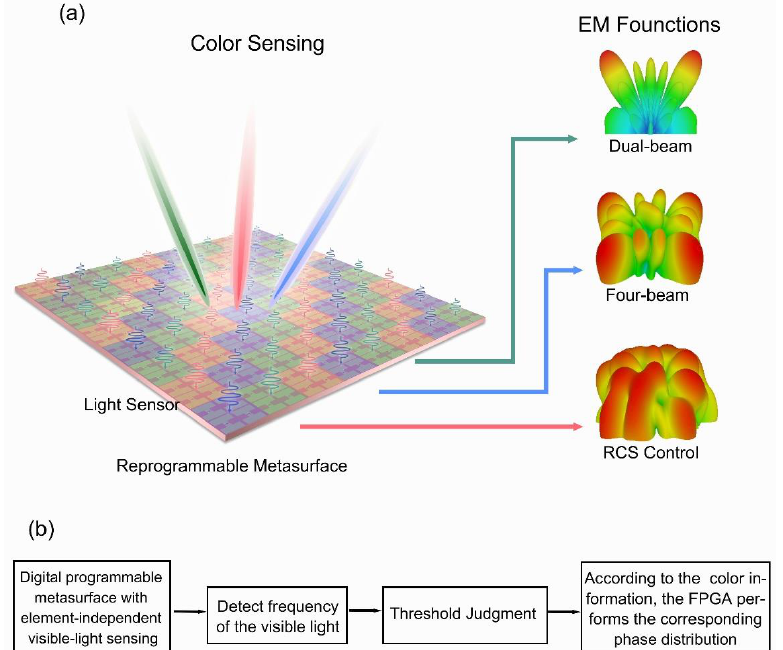
Figure 1. ( a ) Schematic illustration of the digital programmable metasurface. When the digital programmable metasurface detects different color information, its reflection phase patterns will be reprogrammed. ( b ) Illustration of the working principle.